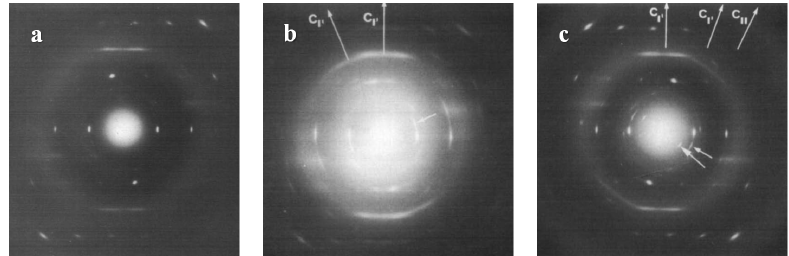
Figure 17. Electron diffraction patterns of iPBu melt-crystallized on 4-chlorobenzoic acid. ( a ) A single set asymmetric electron diffraction pattern of iPBu; ( b ) Two sets of form I’ crystals with molecular chain orientations, indicating a major and a minor component; ( c ) Two sets of form I’ crystals with chain orientations 22 ◦ apart and one set of form II chain orientation at 11 ◦ and 33 ◦ from the minor and major chain directions, respectively. Reproduced with permission from Ref. [118], copyright